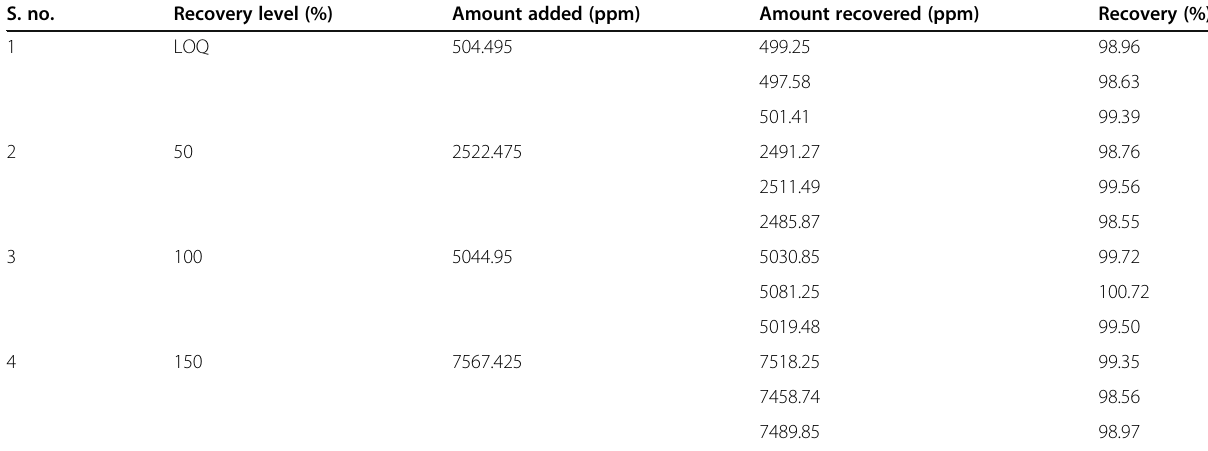
Table 11 Results of recovery study for isopropyl alcohol S. no.